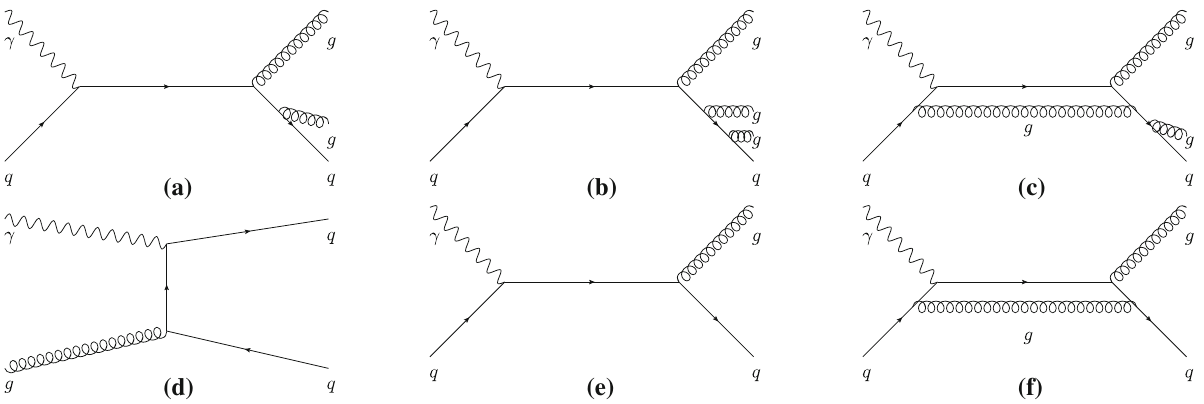
Fig. 1 Representative Feynman diagrams of the partonic subprocess in γ ∗ + p scattering which are included in the numerator (first line) and denominator (second line) of Eq. (3). Here, the virtual photon is denoted by a wavy line and the gluon by a curled line